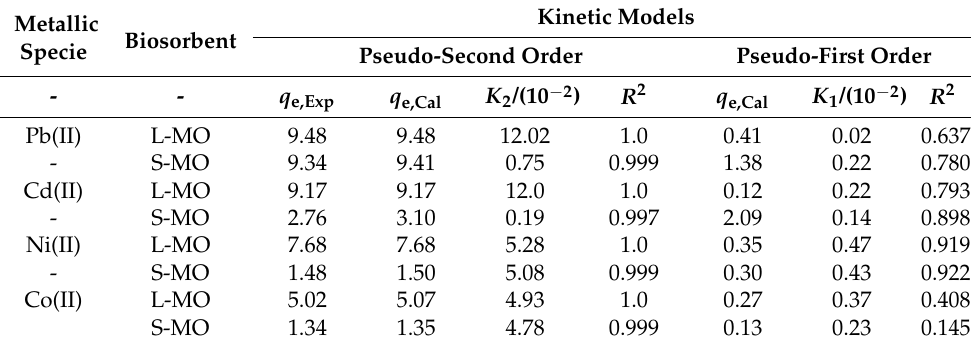
Table 1. Kinetic parameters for the sorption of Pb(II), Cd(II), Ni(II), and Co(II) by L-MO and S-MO.